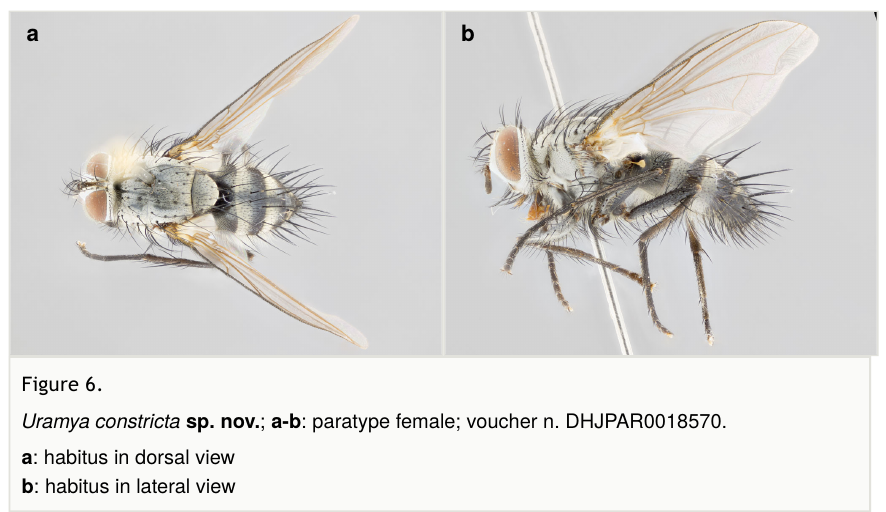
Uramya constricta sp. nov. ; a-b : paratype female; voucher n.